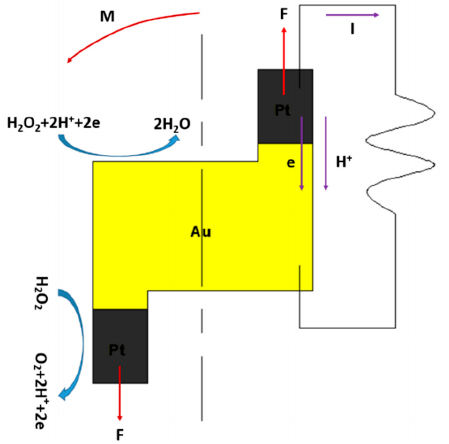
Figure 1. The mechanism of self-electrophoresis of Pt/Au hybrid nanorobot.